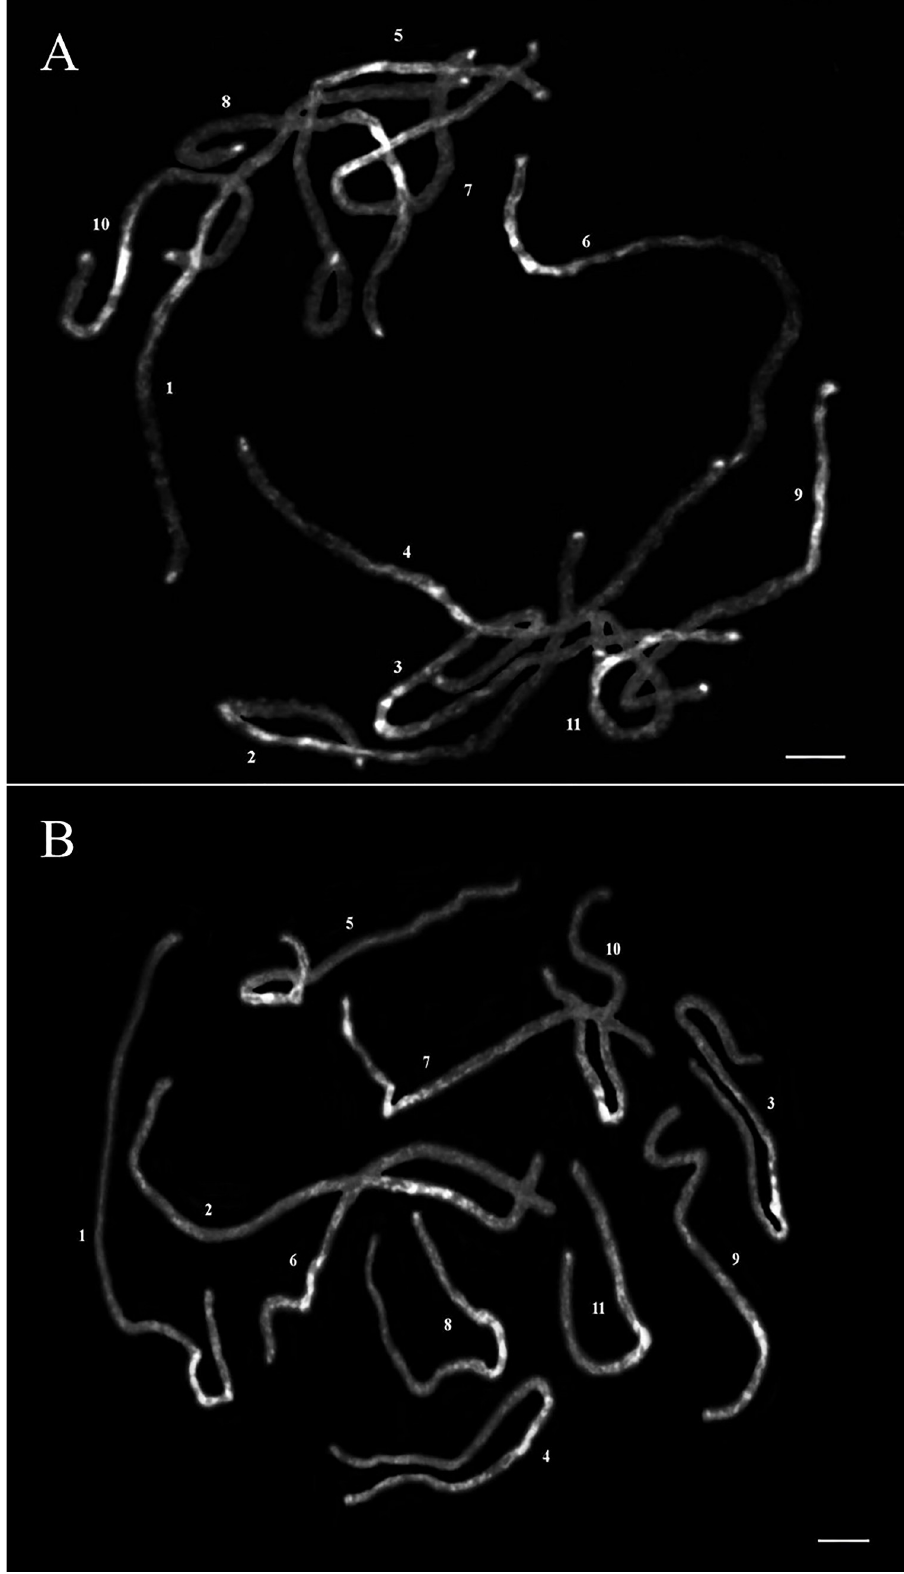
Fig 1. Pachytene chromosomes of J . curcas (A) and J . integerrima (B) with DAPI staining converted to a black and white image to observe distribution of euchromatin and heterochromatin on pachytene chromosomes. Bar = 5 μ m. https://doi.org/10.1371/journal.pone.0208549.g001 PLOS ONE | https://doi.org/10.1371/journal.pone.0208549 December6,